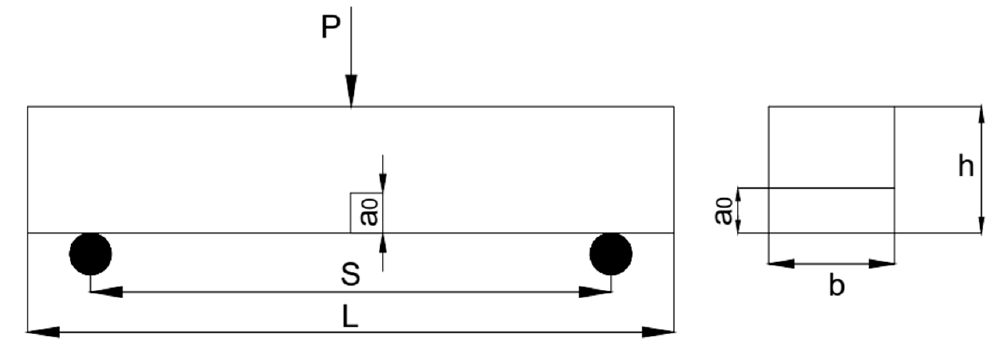
Figure 2. Sketch of the specimen shape and dimension. The test materials were appropriately cleaned by removing the impurities before fabricating the SFHSC specimens. The SFHSC specimens were formed using a mixer to mix the concrete, and a vibration table was used for forming. The specimens were cured for 28 days at a temperature of 20 ± 2 ◦ C and a relative humidity of no less than 95%. The test age was 60–70 d. The mixed concrete and processed SFHSC specimens are shown in Figure